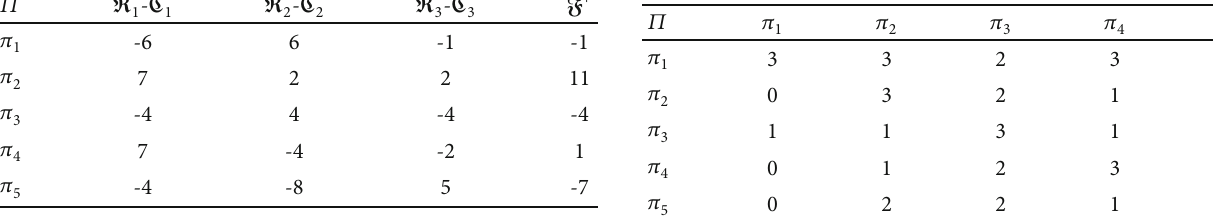
Table 15: The comparison table of Table 12.